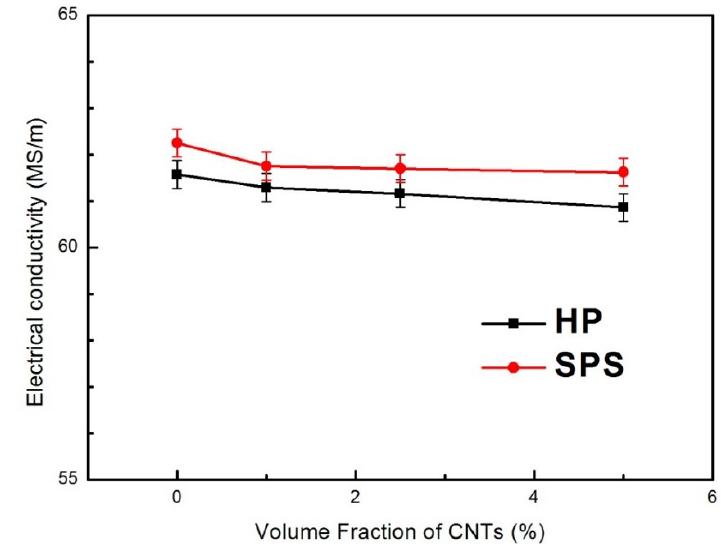
Figure 8. Electrical conductivity of the CNTs@ Ag/Ag composites prepared via SPS and HP.